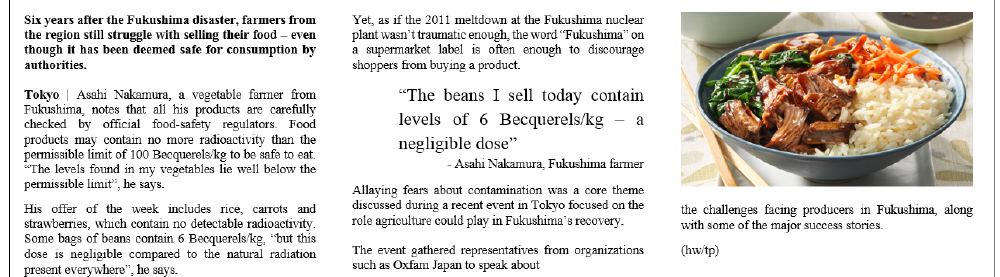
Figure A1. Experimental stimuli (translated from Dutch to English).